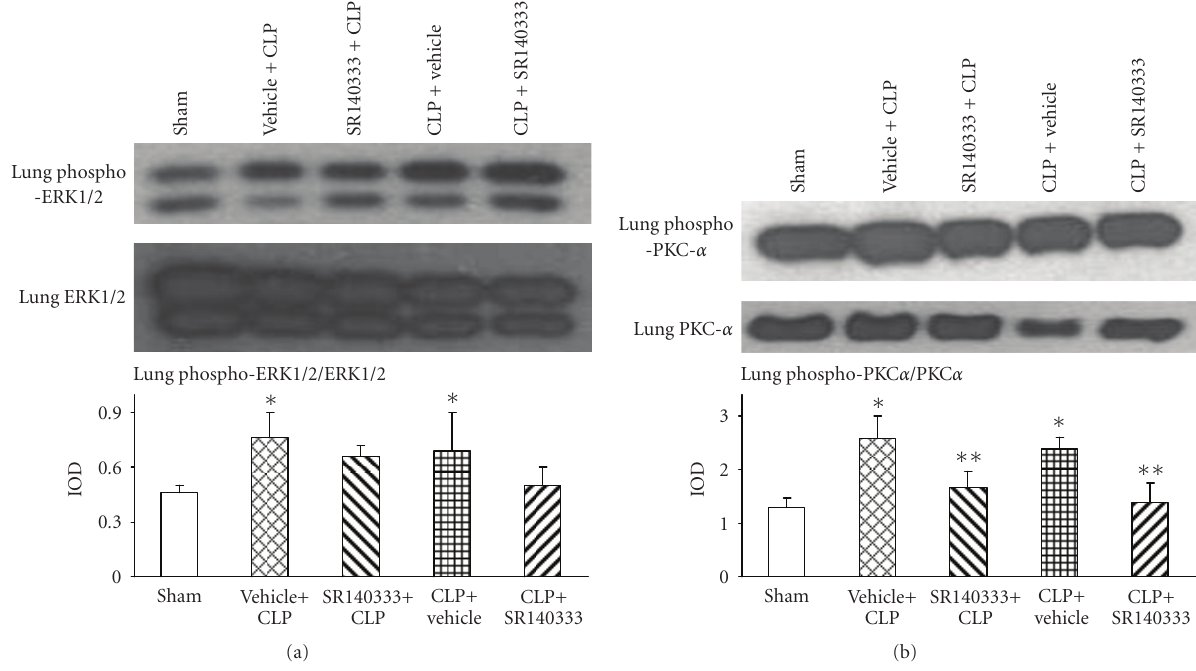
Figure 3: E ff ect of SR140333 administration, either 30 minutes before or 1 hour after CLP, on lung (a) Phospho ERK1/2 and (b) Phospho- PKC α. Results shown are the mean ± S.E.M ( n = 6 in each group). “Vehicle + CLP” and “SR140333 + CLP” represent the groups that received vehicle and SR140333 treatment, respectively, commencing 30 minutes prior to CLP. “CLP + vehicle” and “CLP + SR140333” represent the groups that received vehicle and SR140333 treatment, respectively, 1 hour after CLP. Upper panels show representative western blot gel pictures of phosphorylated and total ERK1/2 and PKC α for each of the groups. ∗ P < . 05 when vehicle-treated CLP animals were compared with sham group animals; ∗∗ P < . 05 when SR140333-treated CLP animals were compared with vehicle-treated CLP animals. CLP: cecal ligation and puncture; ERK: extracellular signal regulated kinase; IOD: integrated optical density; PKC: protein kinase C.